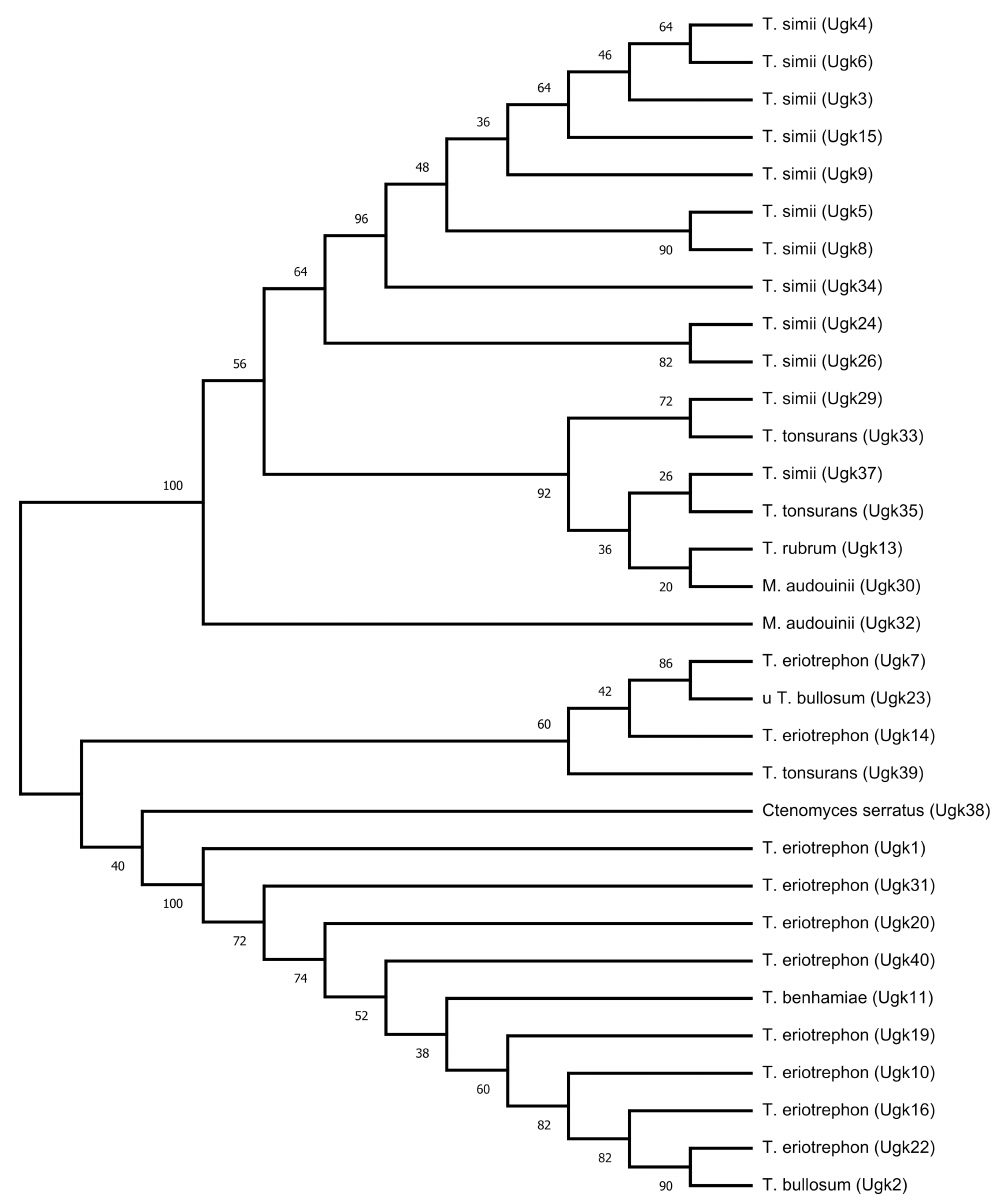
Figure 2. Phylogenetic tree of 32 representative dermatophyte species based on analysis of 28S rRNA gene sequences. The evolutionary history was inferred using the neighbour-joining (NJ)